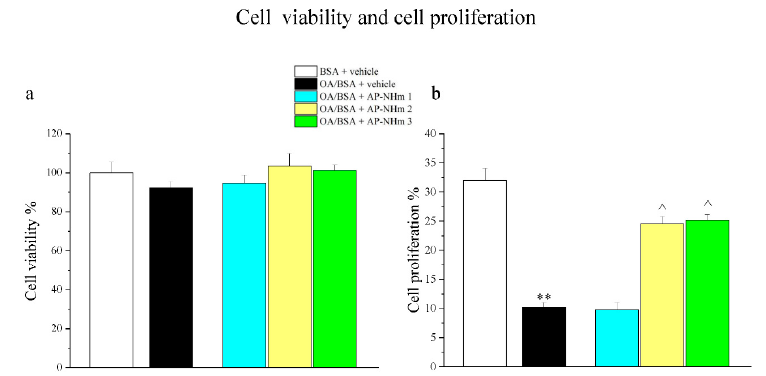
Figure 1. Effects of oleic acid (OA) and AP-NHm on HepG2: cell viability ( a ) and cellular proliferation ( b ). HepG2 were incubated with 0.5-mM oleic acid (OA) in 1% bovine serum albumin (BSA) (OA/BSA) or BSA alone for 24 h in co-treatment or in post-injury recovery treatment (48 h) with AP-NHm 1, 2, 3. ** p < 0.01 vs. BSA + vehicle; ^ p < 0.05 vs . OA/BSA + vehicle.